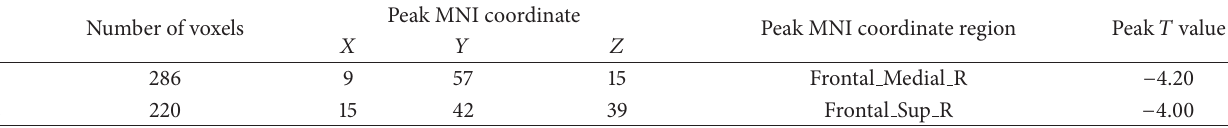
Table 5: Significant connectivity differences to the PCC between two groups with their